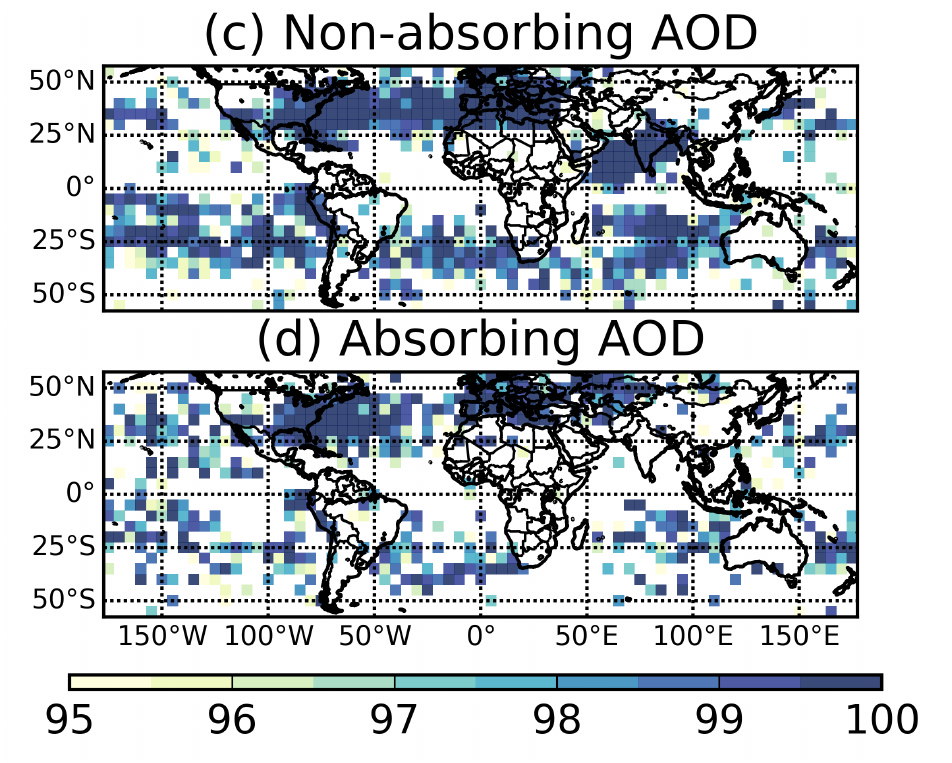
Figure A2. Confidence levels (1- p value ) in % for the slope of the least square lines fitting the time series of annual mean ( a ) total, ( b ) nonspherical, ( c ) nonabsorbing, and ( d ) absorbing aerosol optical depths during the 17 years between March 2000 and February 2017.